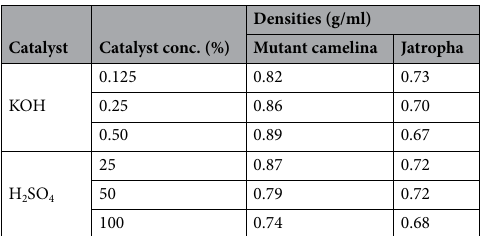
Table 3. Densities (g/ml) of biodiesel produced from mutant camelina and jatropha.